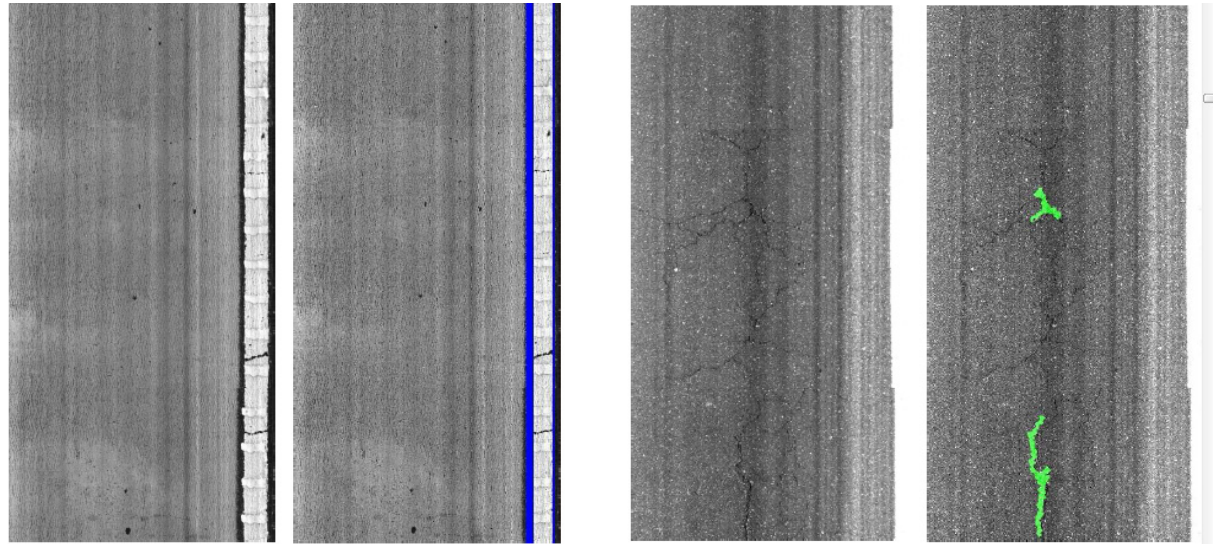
Figure 19. Non-crack false positives. Left : dark and narrow longitudinal texture band detected as joint. Right : wide cracks detected as sealed